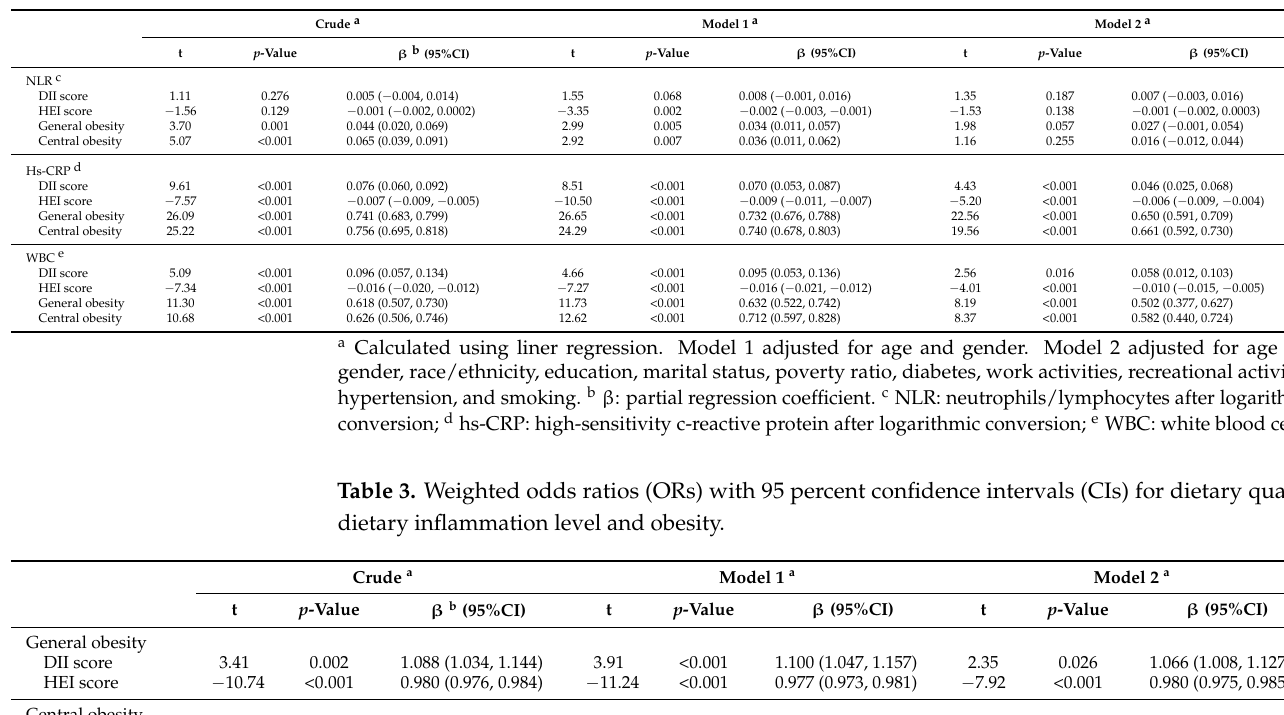
Table 2. Partial regression coefficient ( β ) with 95 percent confidence intervals (CIs) for diet score, obesity, and inflammation markers. Model1a